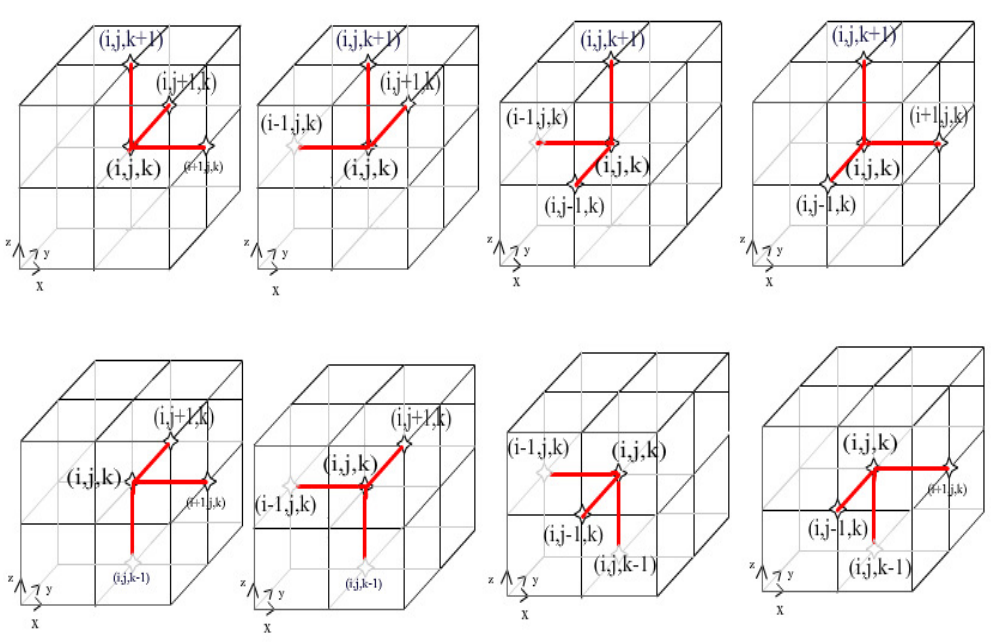
Figure 1. The asymmetric iterative schemes (5)–(12) for the 3D Poisson equation with the relaxation factor ω